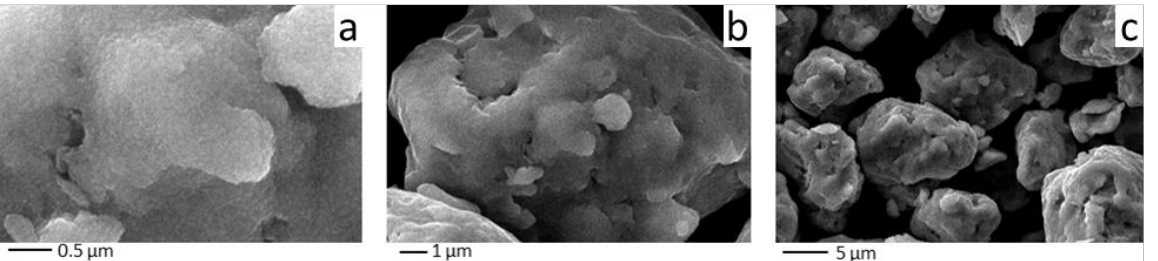
Figure 8. SEM images of the powder particles formed after 24 min of milling of the ternary (Cu+Fe) + Al mixture at different magnifications ( a ) ×30,000 ( b ) ×10,000 and ( c ) ×3,000.